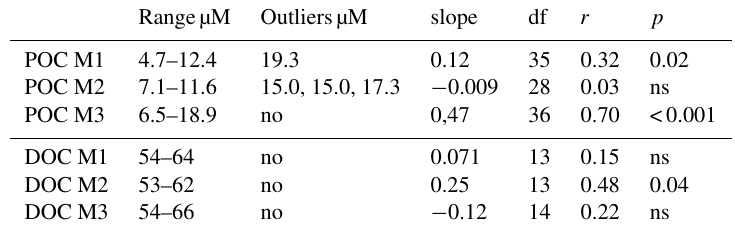
Table 4. Linear regression fits on temporal trends of POC and DOC in M1, M2 and M3 from days 5 to 23. DOC has been sampled only at 6m depth in the three mesocosms. df: degree of freedom, r : Pearson correlation coefficient, p : probability, ns: not significant. For POC trend, some outliers have been suppressed from the